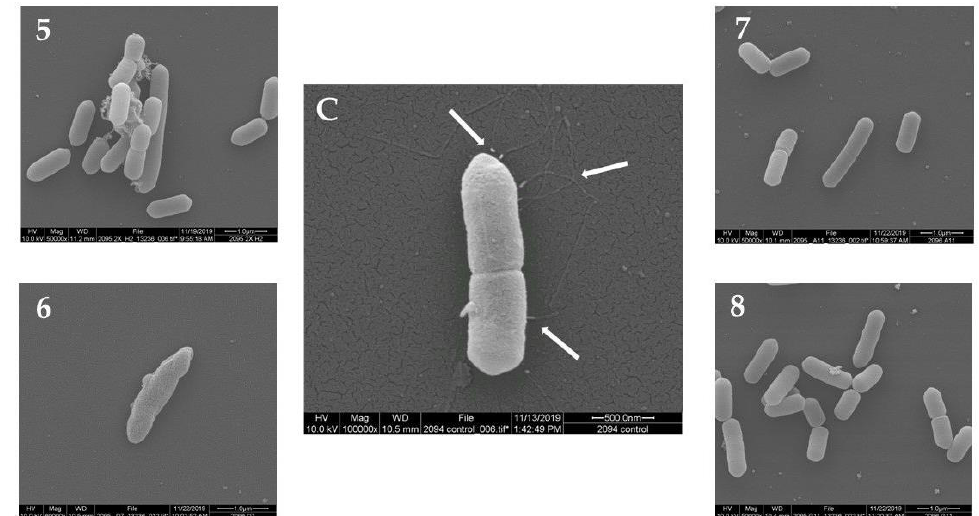
Figure 1. Morphology of L. monocytogenes F2365 cells treated with plant extracts No. 1 – 4 (group A) observed using SEM, in comparison with L. monocytogenes F2365 that was not treated with samples — control (C). White arrows show flagella in C. The black arrow shows pores in the cell membrane. Number/plant species correspondence is shown in Table 1.